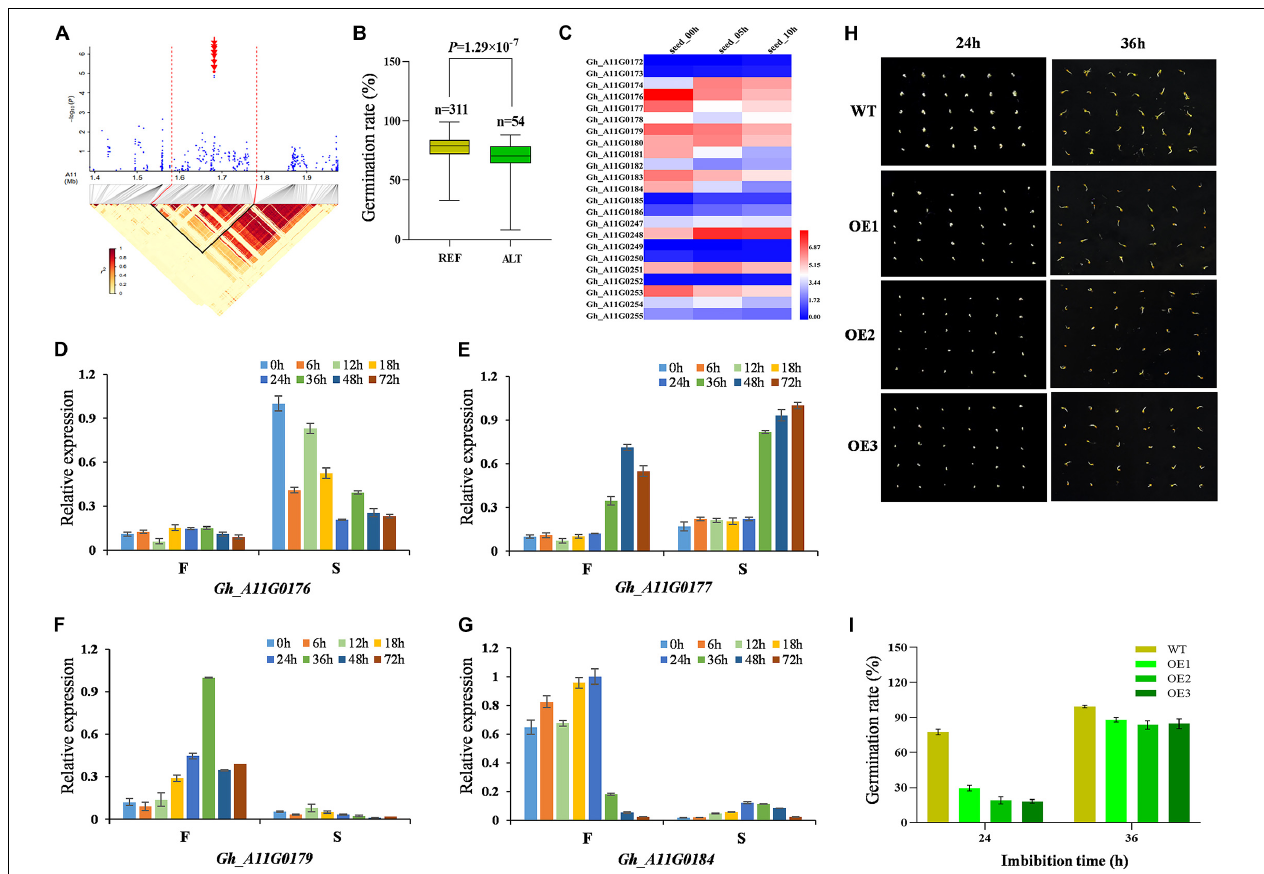
FIGURE 3 | Identification and expression analysis of candidate genes related to seed germination on chromosome A11. (A) Local Manhattan plot (top) for GRA and LD heat map (bottom) surrounding the peak region (1.4–2.0 Mb) on A11. Red dotted lines indicate the candidate region, and the red arrows indicate A11:1681226, A11:1681264, A11:1681275, A11:1681285, A11:1681287, A11:1681352, A11:1681419, A11:1681428, and A11:1681444. (B) Box plots for GRA, based on the significantly associated SNP on A11, n indicates the number of accessions with the same genotype. REF, the reference TT; ALT, the alternate TC. Significant difference was analyzed with a two-tailed t -test. (C) Heat map of the candidate gene expression of chromosome A11 at different cotton seed imbibition stage based on the FPKM value. Red indicates high expression, and blue indicates low expression. (D–G) Relative expression of four candidate genes ( Gh_A11G0176 , Gh_A11G0177 , Gh_A11G0179 , and Gh_A11G0184 ) between F (cotton variety with fast germination: Jinmian2) and S (cotton variety with slow germination: Qunkemian) via qRT-PCR at 0, 6, 12, 24, 36, 48, 60, and 72 h, Ghhistone3b was used as an internal control. The data were normalized to the maximum value. The error bars indicate ± SE; n = 3 independent biological replicates. (H) Germination phenotype of Gh_A11G0176 overexpressing lines and the WT at the seed germinating stage 24 and 36 h in Arabidopsis. WT, wild-type plants. (I) GRA of overexpressing lines and the WT in